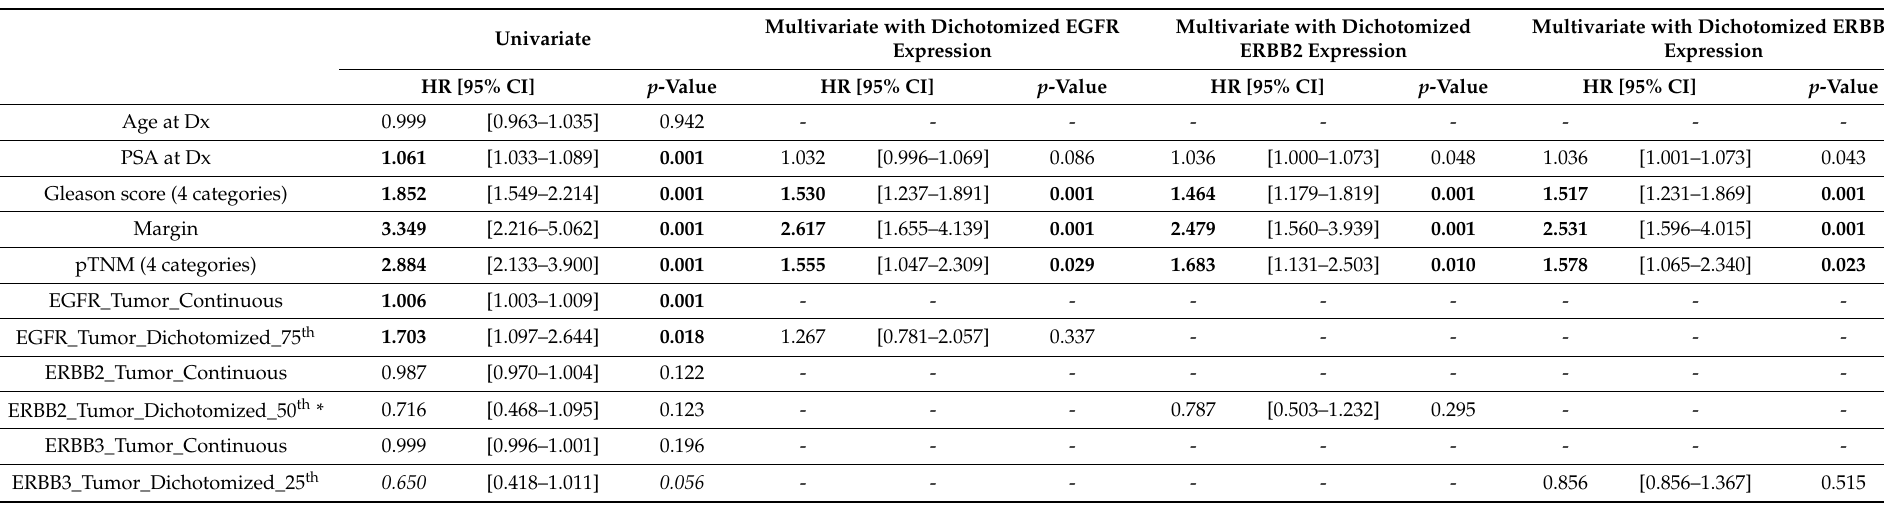
Table 2. Univariate and multivariate Cox regression analyses of single receptors using the BCR at five years as an endpoint. Multivariate with Dichotomized EGFR Multivariate with Dichotomized Multivariate with Dichotomized ERBB3 Univariate Expression ERBB2 Expression